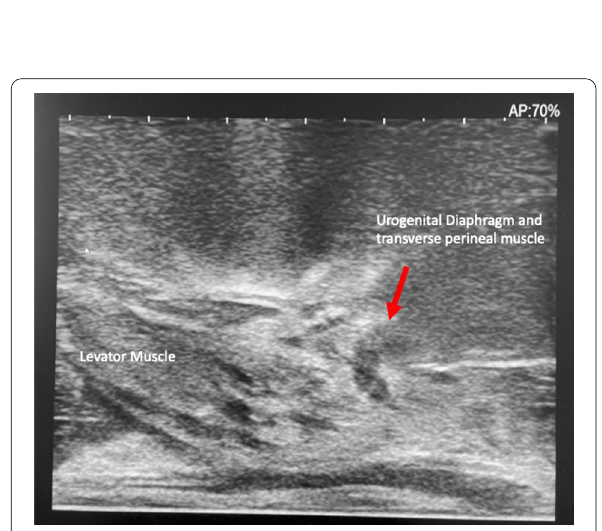
Fig. 9 Prominent urogenital diaphragm in a younger